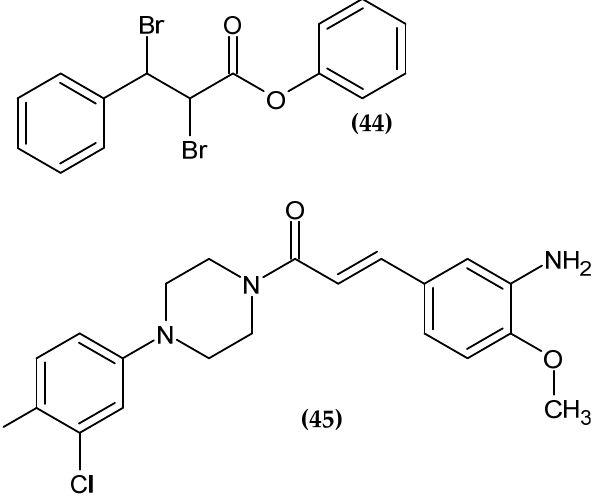
Figure 11. Cinnamic acid derivatives with anti-melanoma activity.